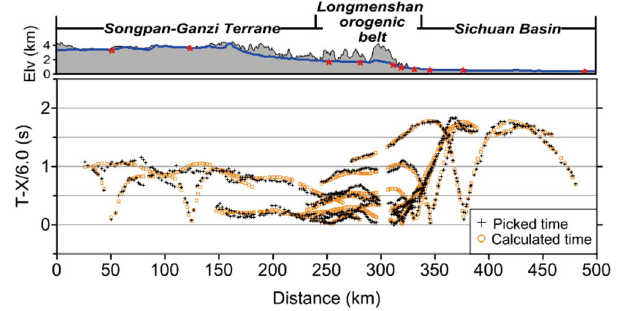
Figure 2. Distribution of first-arrival traveltimes. Black crosses denote traveltimes picked from the wide-angle seismic data and brown circles denote the final inverted traveltimes. These traveltimes are reduced by a velocity of 6 km/s. The top plate shows the elevation along the profile with the tectonic units labelled. The blue line and red stars denote receiver and shot positions,